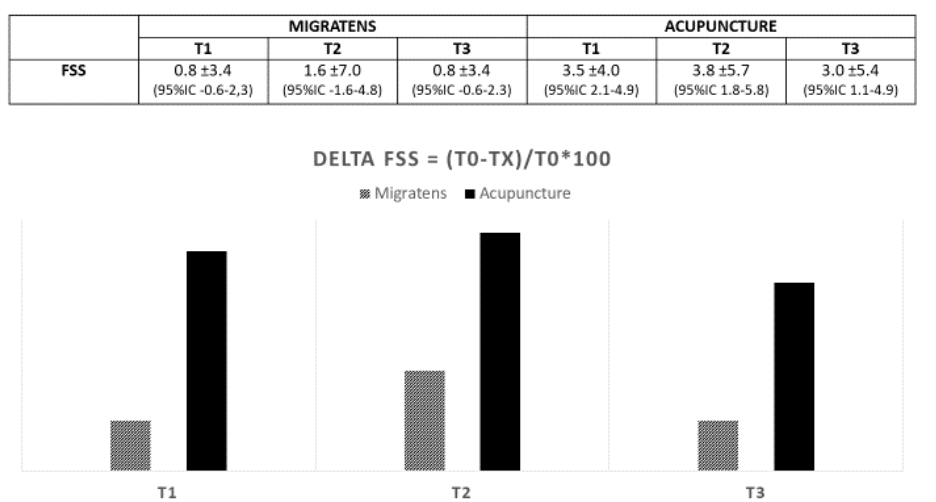
Figure 8. Reduction difference in FSS values in the two treatment groups during observations (values are expressed as mean difference ±SD).